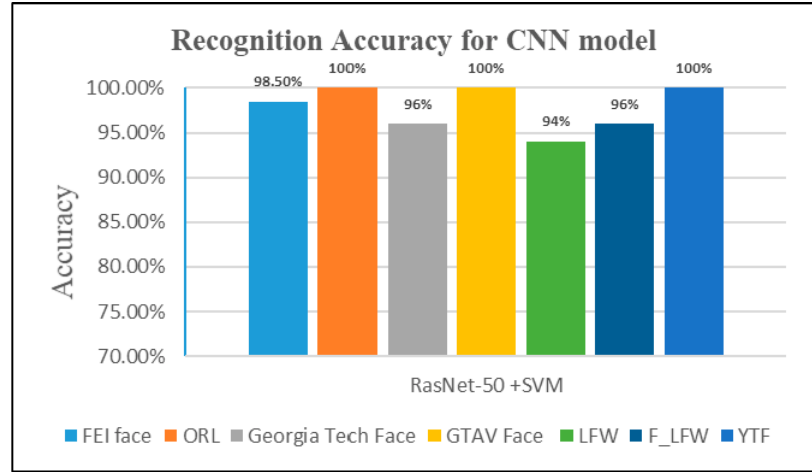
Figure 8. Recognition accuracy for ResNet-50 with SVM.